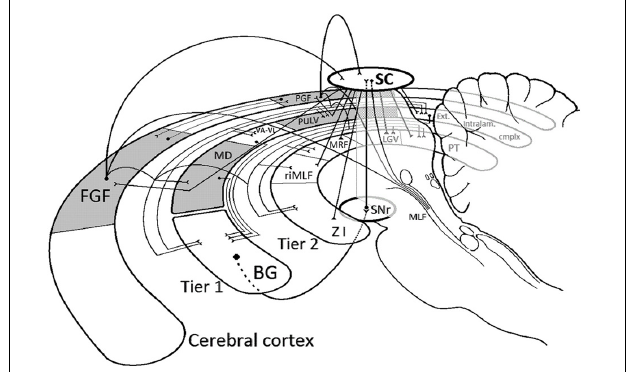
FIGURE 2 | Schematic depiction of the basic connective relations of the supranuclear apparatus for gaze control discussed in the text. The figure may conveniently be inspected by proceeding from the two principal cortical “gaze fields,” the frontal (FGF) and the parietal (PGF), which are mutually connected. Projections descending from them are shown as curvilinear trajectories, further distributed to components of Tier 1 [dorsal thalamus and basal ganglia (BG)] and Tier 2 (ventral thalamus and midbrain) via connective “buses” (for graphical economy). Connections between components of Tiers 1 and 2 are omitted to avoid clutter, with two exceptions: Tier 1 projections destined for the basal ganglia (BG) are shown, as are the main connections of both tiers with the superior colliculus (SC). Both cortical gaze fields issue direct projections to the colliculus as well as to the brainstem orienting apparatus. The latter has a token representation in Tier 2 in the form of its most rostral member, the rostral interstitial nucleus of the medial longitudinal fasciculus (riMLF). Connections to the rest of that apparatus are shown descending along the medial longitudinal fasciculus (MLF), and include the direct collicular descending projections to the paramedian brainstem and spinal cord. The colliculus returns projections to the cortical gaze fields via synapses in the paralaminar MD (MD) and Pulvinar (PULV), shown as straight lines deflected in the respective dorsal thalamic nuclei. Note, finally, that the chief descending route from Tier 1 to the brainstem orienting apparatus proceeds from the basal ganglia (which also receive direct cortical gaze field projections) via its midbrain outpost, the substantia nigra pars reticulata (SNr), to the superior colliculus. Together with the rest of its connectivity sketched here, this places the colliculus in the position of connective superhub in the supranuclear apparatus for gaze control, a concept further explicated in the text. Solid dots mark the source of a projection. The termination of a projection is shown ending in an open “Y.” Filled triangles indicate reciprocal connections. Ext. intralam. cmplx, extended intralaminar complex, which includes the suprageniculate and limitans nuclei; VA-VL, ventral anterior and ventrolateral nuclei; PT, pretectal nuclei; LGV, ventral lateral geniculate nucleus (pregeniculate of primates); MRF, midbrain reticular formation; ZI, zona incerta. The figure was inspired by the